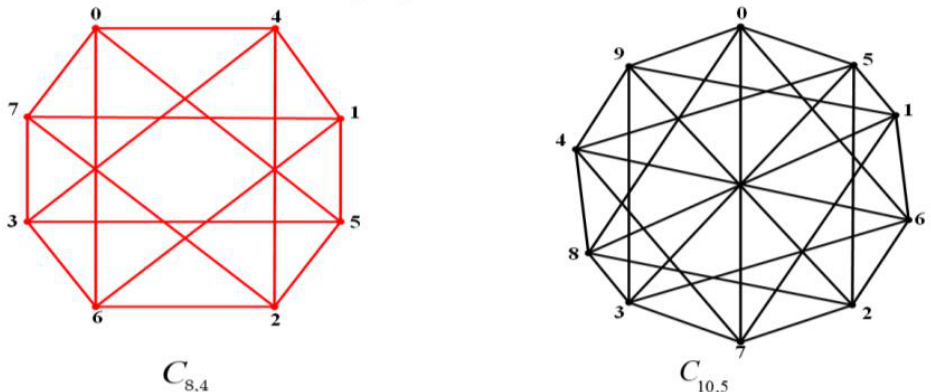
Figure 2. The labeling of the circulant graphs 𝐶 8,4 and 𝐶 10,5 .